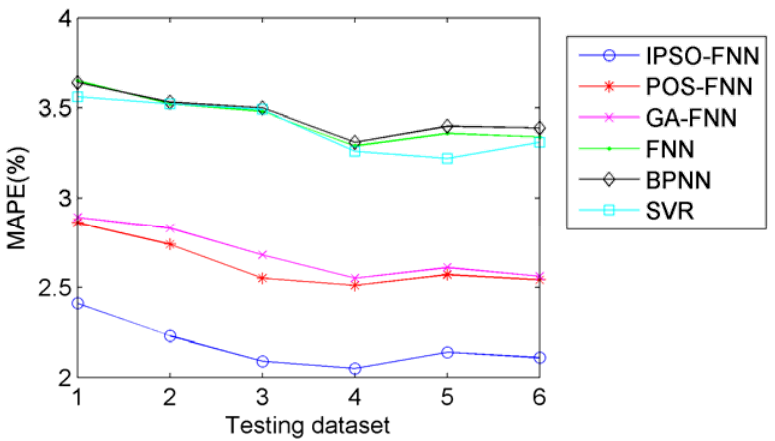
Figure 6. Comparison of mean absolute percentage error.